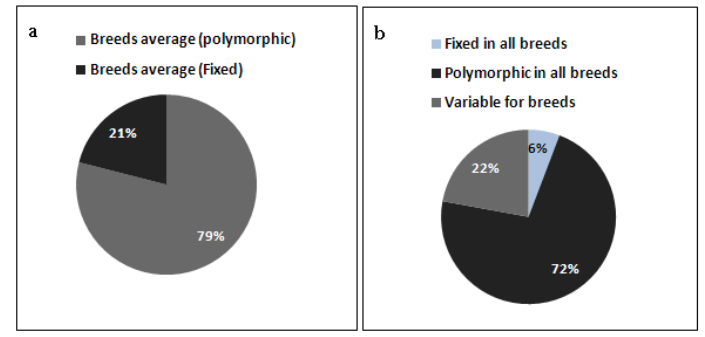
Figure 1. (a) average polymorphic and fixed SNPs in the breeds, (b) degree of polymorphic and fixed SNPs sharing among the six cattle breeds; SNP with any missing frequency was excluded from the analysis.